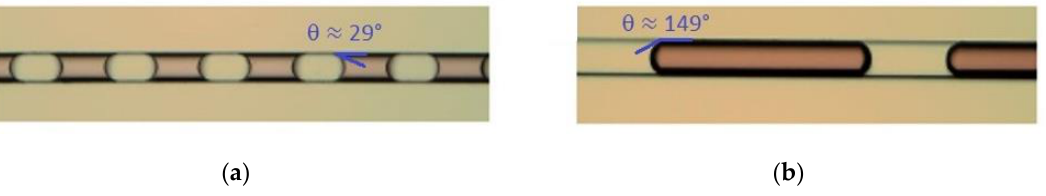
Figure 2. Visualization of the oil-water interface in a straight channel in the ( a ) hydrophilic (WW) and ( b ) hydrophobic (OW) devices. The images were used to measure the water phase contact angle for both cases.